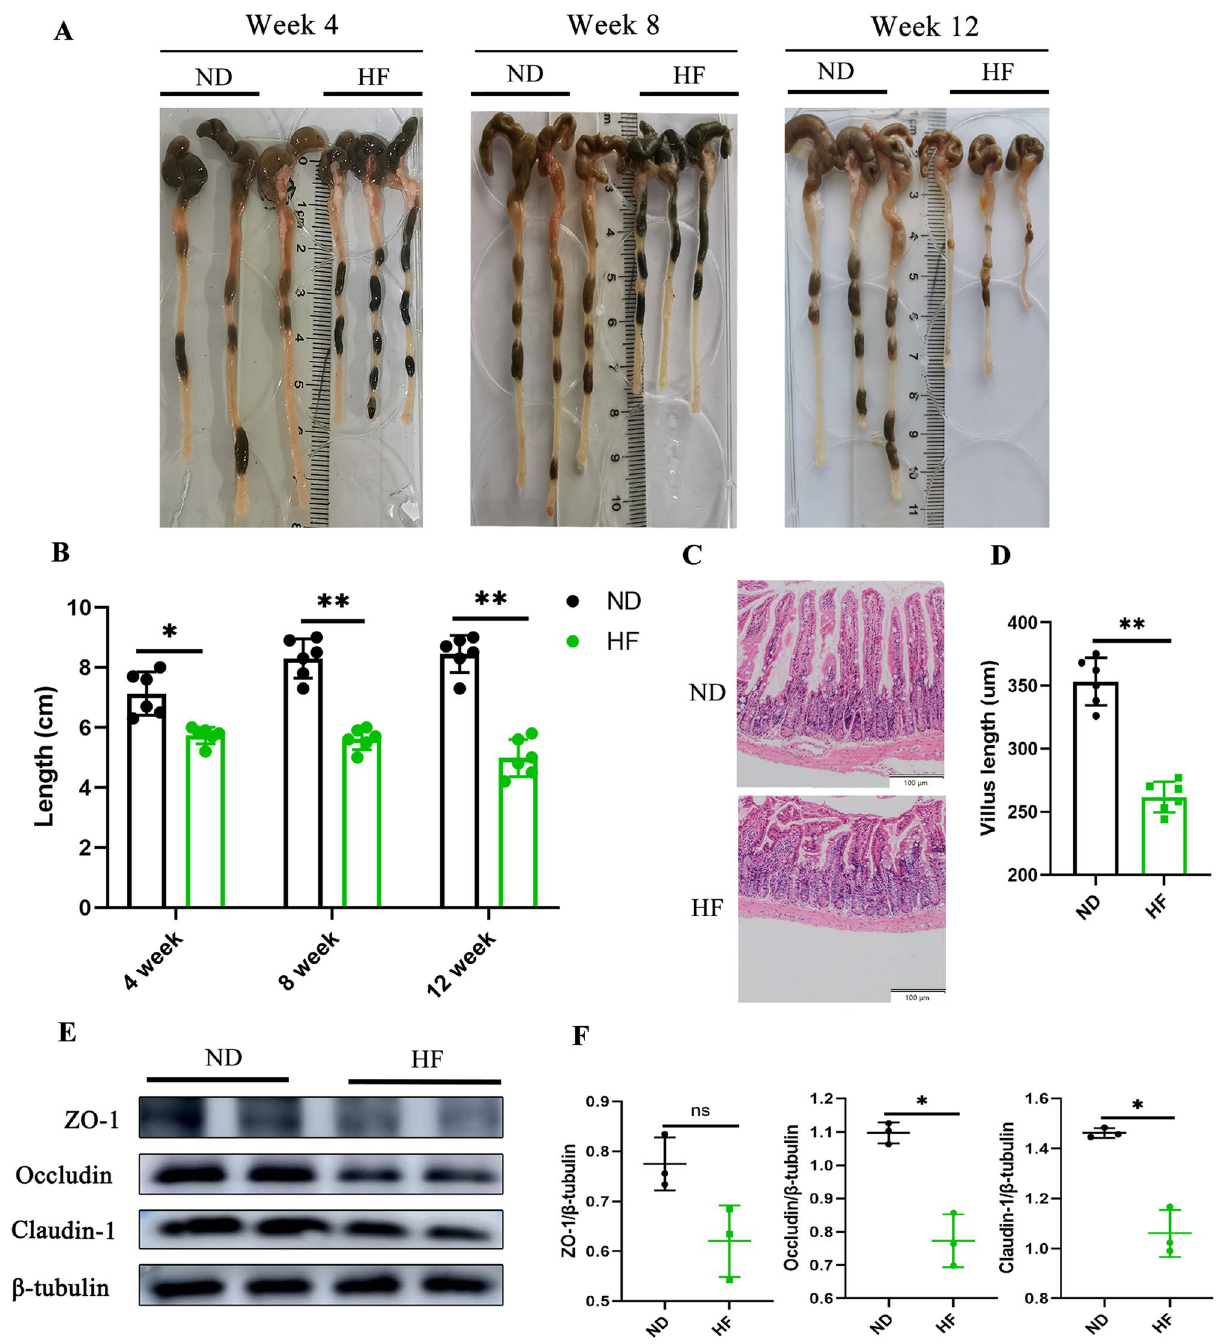
Figure 5. HF diet alters the intestinal morphology and gut permeability. ( A ) Representative images of the colon of mice at 4, 8, and 12 weeks. ( B ) Quantified colon length. ( C ) Representative H&E staining images of villi in the jejunum at 4 weeks. Bar: 100 µm. ( D ) Quantified villus length. ( E ) Representative images of Western blots for tight junction proteins (ZO-1, occludin, and claudin-1) at 4 weeks. ( F ) Gray-scale value analysis of ZO-1, occludin, and claudin-1 at 4 weeks. The student’s t-test was used to determine statistical significance. * p < 0.05; ** p <